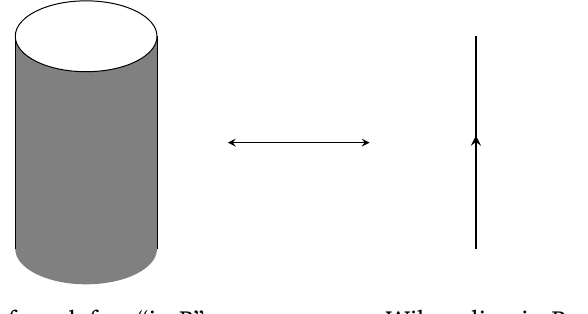
Figure 1: Compactifying a surface defect of 6 d ( 2,0 ) theory of type g along S 1 direc- tion in spacetime leads to a gauge Wilson line defect in 5 d N = 2 g SYM. Equivalently, a gauge Wilson line in the 5 d theory lifts to a circle compactified surface defect of the 6 d theory. If the Wilson line transforms in representation R of g , then we label the the corresponding surface defect by the representation R